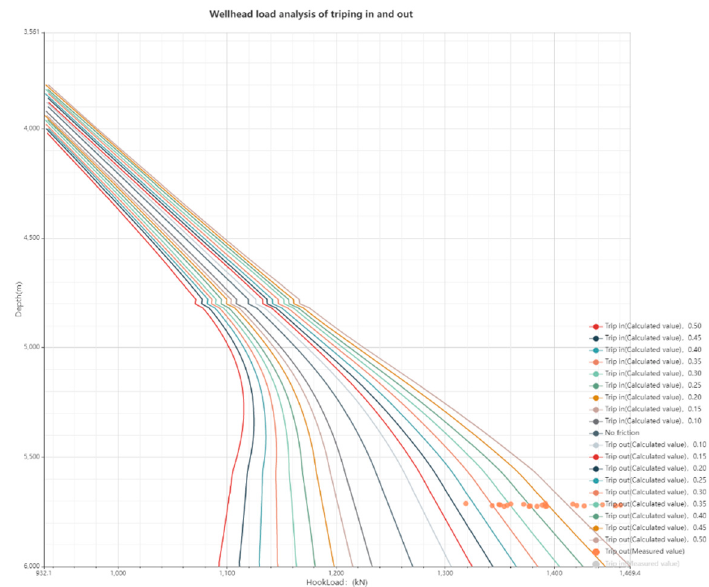
Figure 3. Distribution of measured hookload for stuck pipe well.